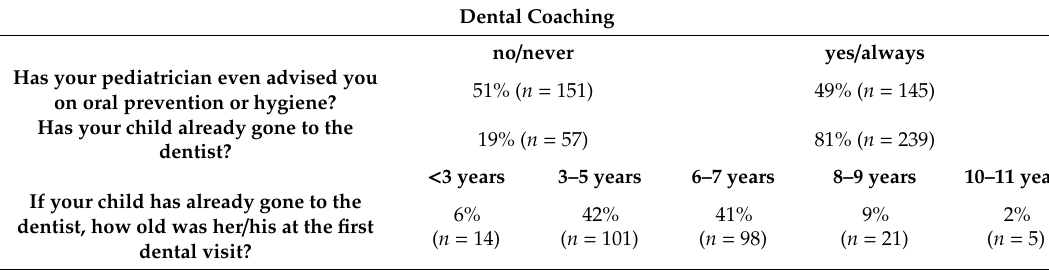
Table 3. Questions and data on dental coaching.